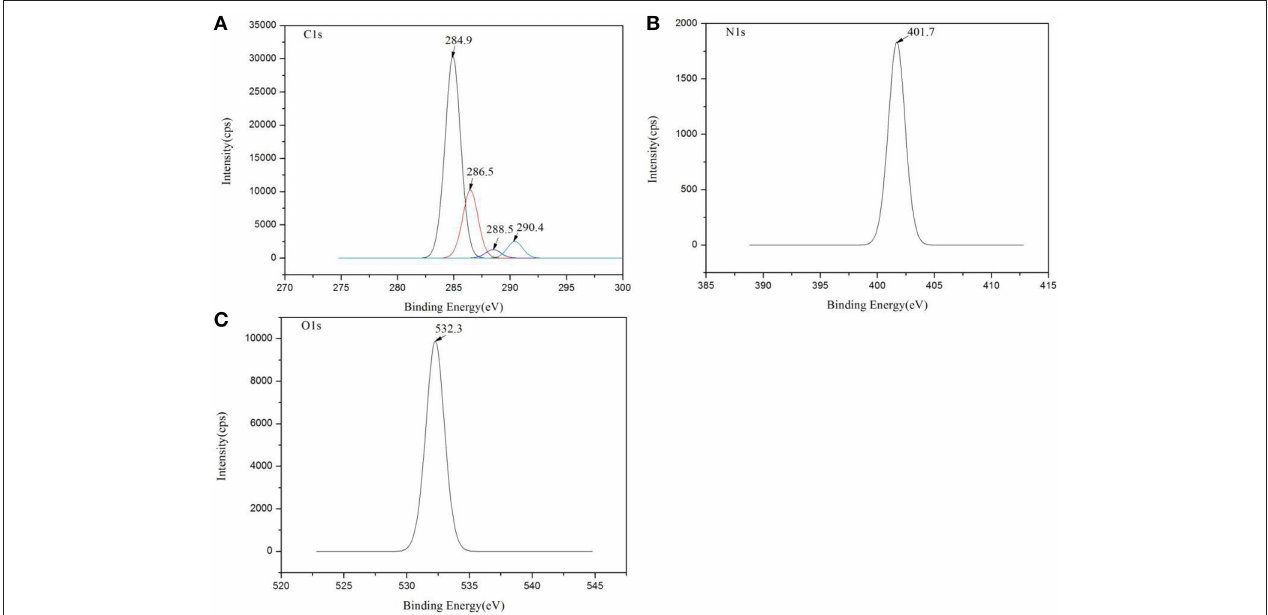
FIGURE 5 | X-ray photoelectron spectrum of the C1s (A) , N1s (B) , and O1s (C) for PVDF/IL.